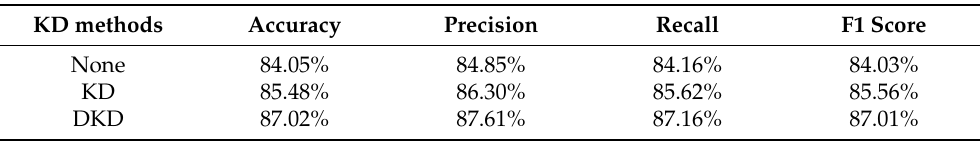
Table 3. The experimental comparison results of the different knowledge distillation methods. The experiments were completed under the data augmentation condition implemented using the student model